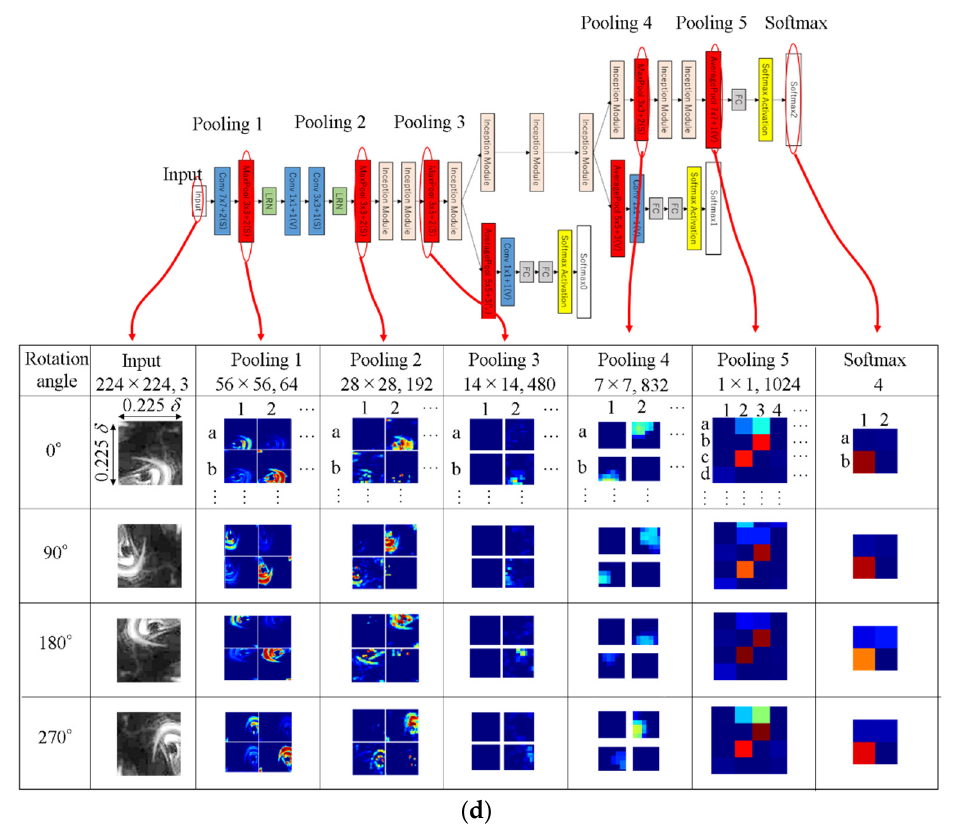
Figure 3. Accuracy of determination for rotated images: ( a ) W0.9 δ , ( b ) W0.225 δ , and ( c ) W0.05 δ . This CNN was trained by original image (0°). ( d ) Feature map for each pooling layer for each rotated image based on the correct answer verification image of x d = 20 δ for W0.225 δ